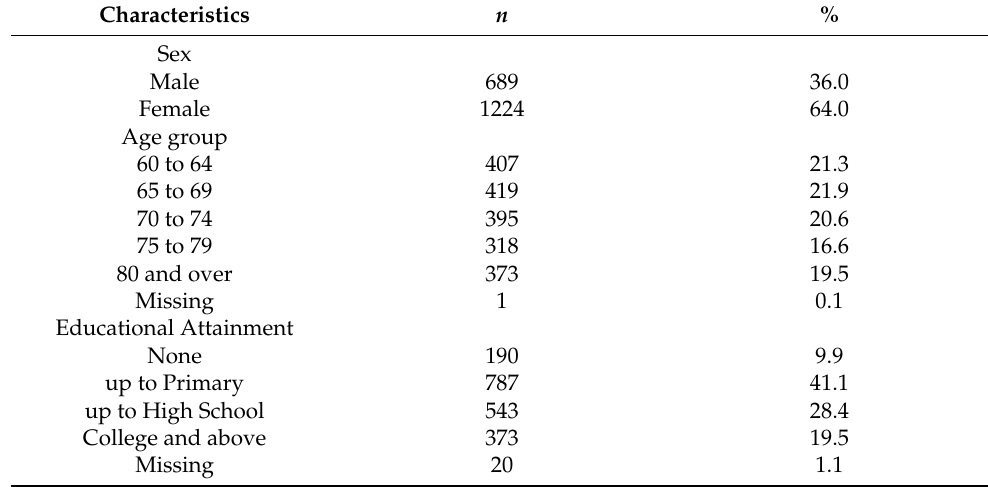
Table 2. Sociodemographic characteristics of the sample ( n = 1913).